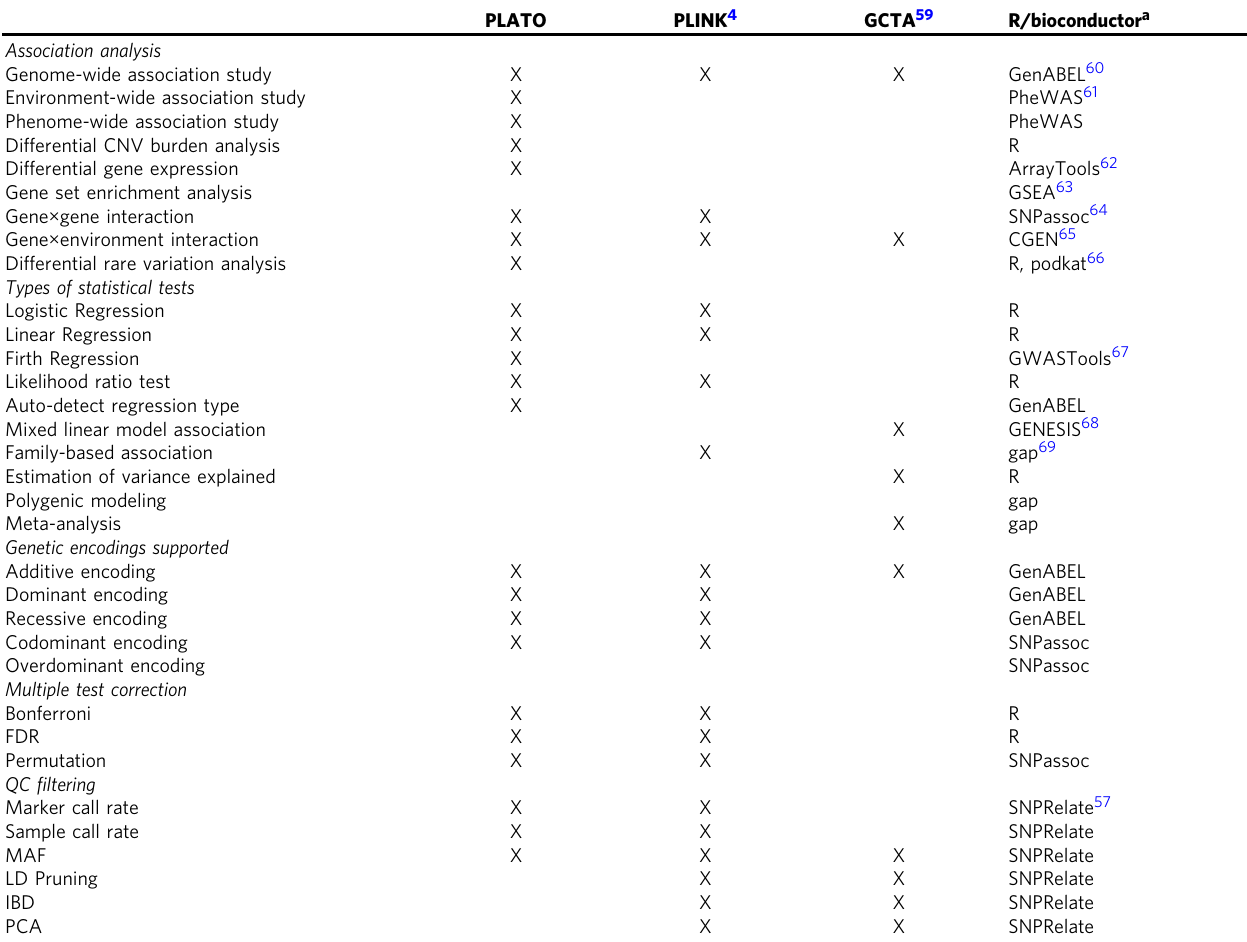
Table 1 An example of the features available in PLATO and other common genomics software